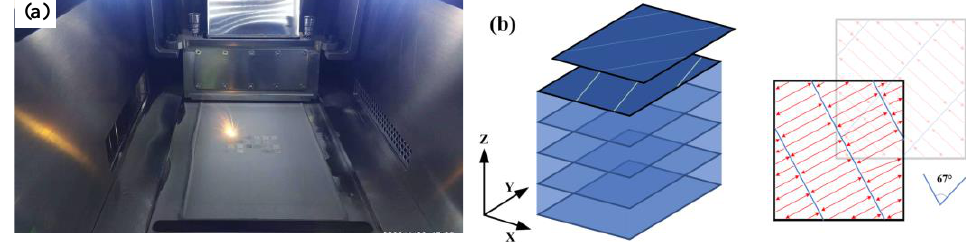
Figure 2. ( a ) Chamber of the SLM equipment. ( b ) Illustration of LPBF scanning strategy.